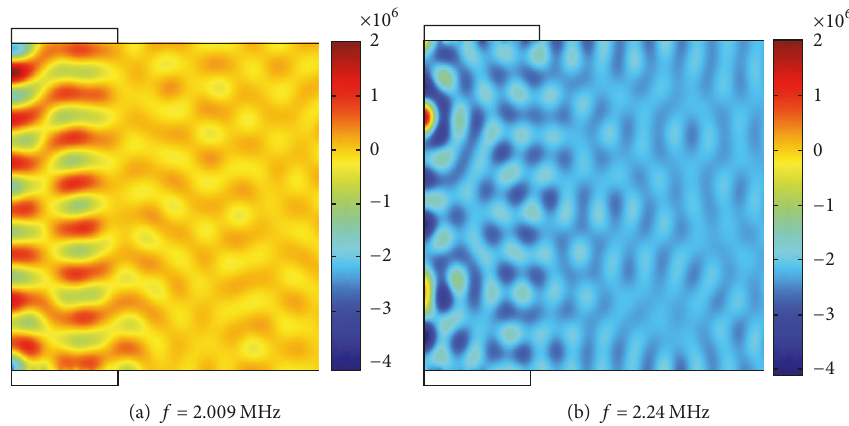
Figure 13: Acoustic pressure distributions in the planar metal wall from FEM simulations.